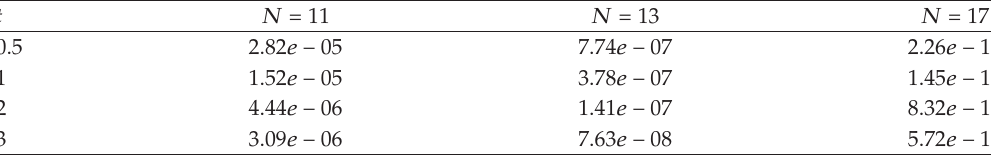
Table 2: RMS errors for Problem 1 with Δ t (cid:6) 0 . 25 using PDQ with Neumann boundary